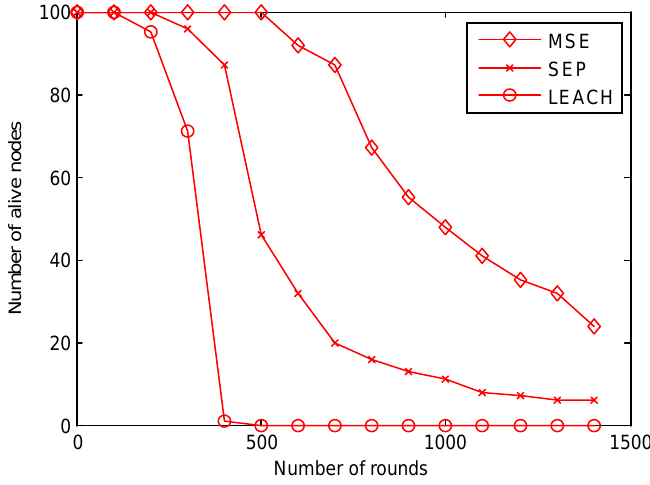
Figure 10. Network lifetime comparison.